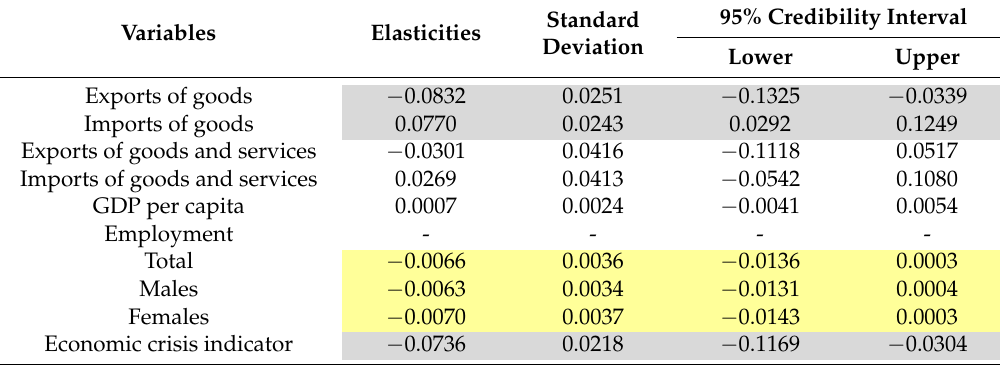
Table 3. Results of the estimation of the models with dependent variable CO 2 total equivalent.